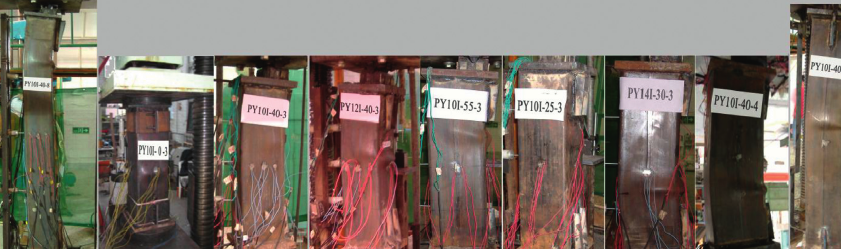
Figure 3: The broken specimens under eccentric load.